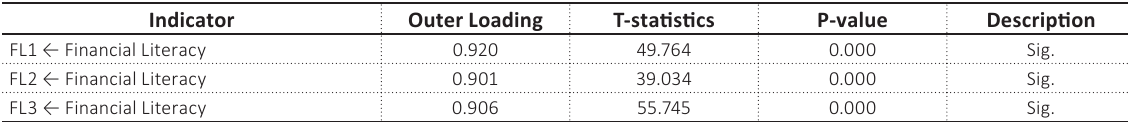
Table 5. Outer loading of financial behavior